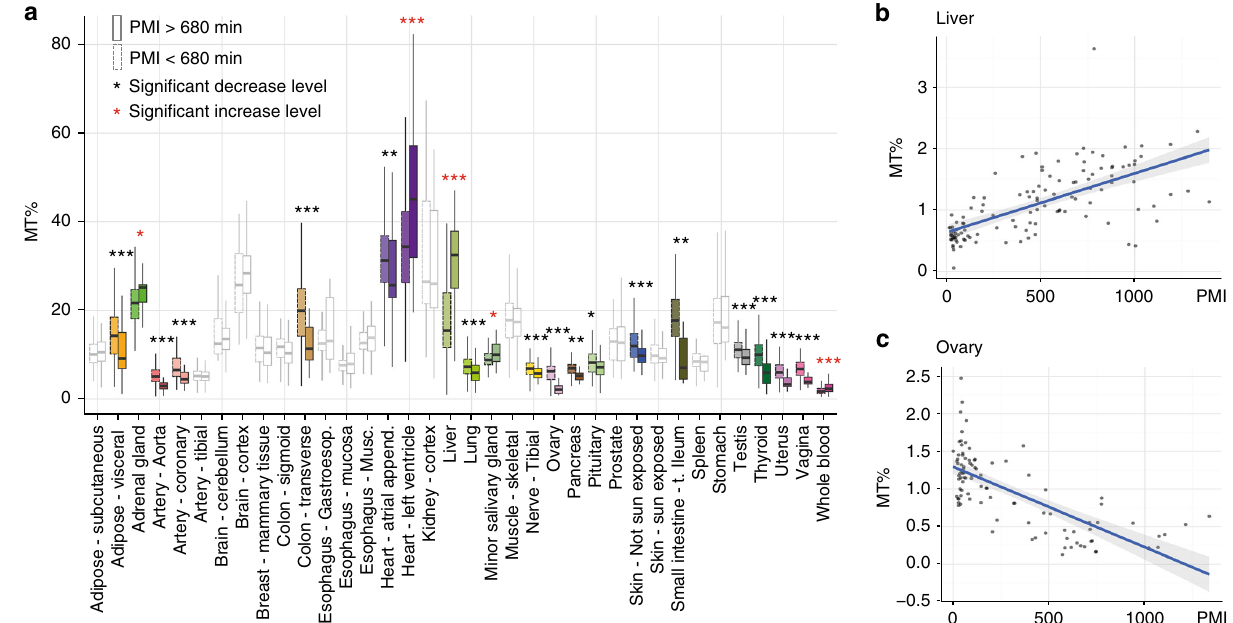
Fig. 4 Effect of PMI on mitochondrial transcription and splicing. a Proportion of RNA-seq reads originating from mitochondrial genes (mtRNA concentration) in early ( ≤ 680) and late ( > 680) PMI intervals. b , c mtRNA concentration depending on PMI in Liver ( b ) and Ovary ( c